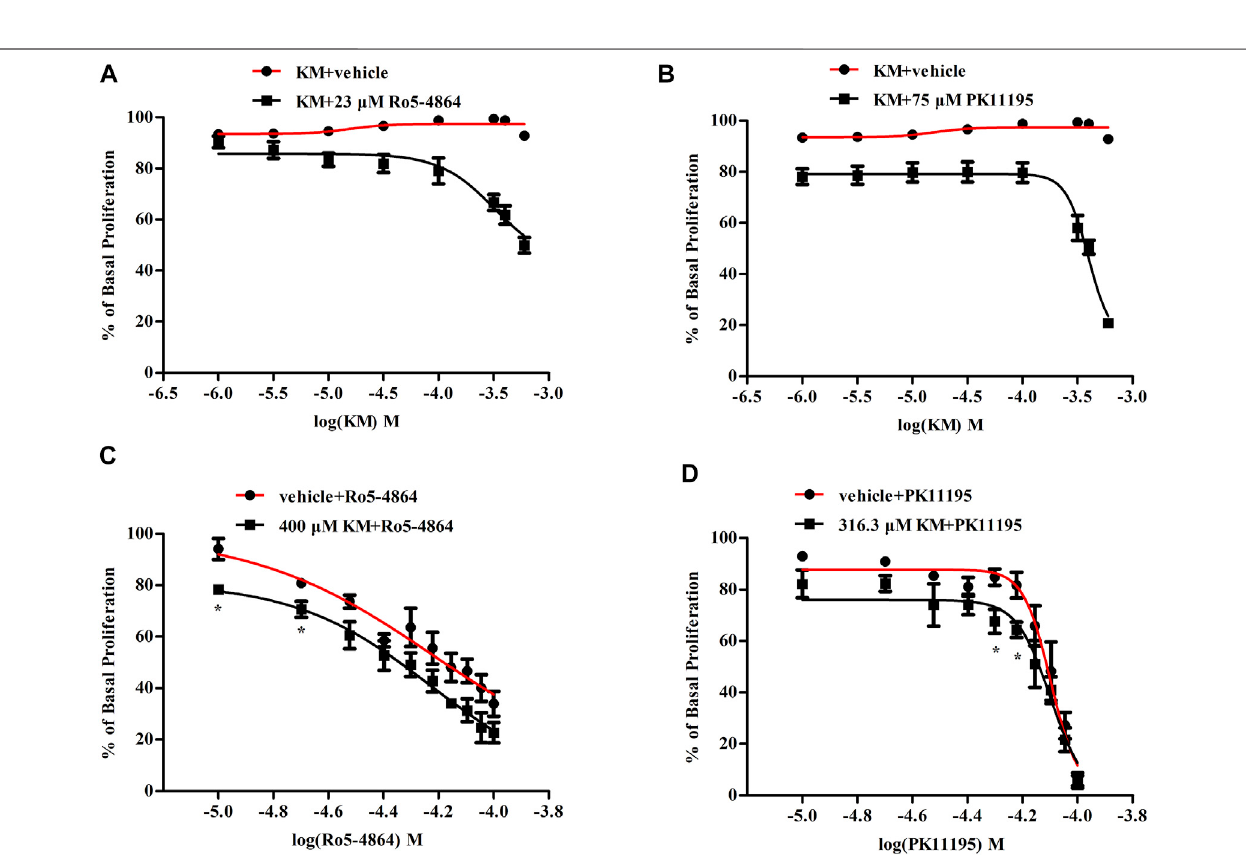
FIGURE 7 | Koumine enhances Ro5-4864- and PK11195-mediated antiproliferation effects in T98G human glioblastoma cells. (A,B) Positive modulation of the antiproliferative effect of an EC 20 concentration of Ro5-4864 (A) and PK11195 (B) by koumine in T98G human glioblastoma cells. (C,D) Dose response curve of the antiproliferative effect of Ro5-4864 (C) or PK11195 (D) in the absence or presence of 400 μ M or 316.3 μ M koumine, respectively. Cell proliferation was determined by the BrdU incorporation assay, which was measured at 370 nm (reference wavelength 492 nm). Cells treated with 0.5% DMSO alone were used as controls. Abbreviations: KM, koumine. The values are expressed as the mean ± SEM of 3 – 5 independent experiments performed in triplicate ( n (cid:2) 3 – 5), * p < 0.05 vs. the corresponding vehicle group.